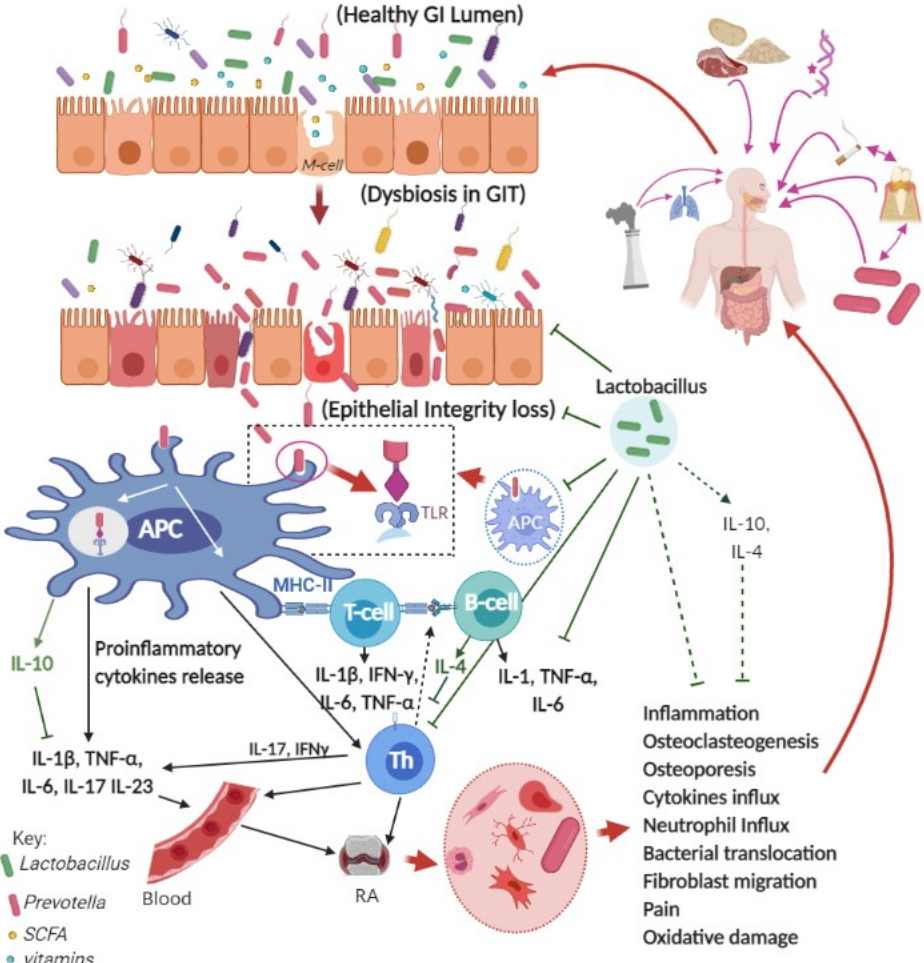
Figure 1. Possible mechanisms of Rheumatoid Arthritis (RA) and the role of Lactobacillus spp. Keys: APC, antigen-presenting cell; GI, gastrointestinal, GIT, gastrointestinal tract; IL, Interleukin; TNF- α , tumor necrosis factor alpha; IFN- γ , gamma interferon; M-cell, microfold cell; Th, Helper T cell; T-cell, T-cell lymphocytes, B-cell, B-cell lymphocytes; green rod-shaped bacteria, Lactobacillus spp.; red rod-shaped bacteria, Prevotella spp.; SCFA, short-chain fatty acids. Figure was made with www.biorender.com (access date: 14 April 2021).